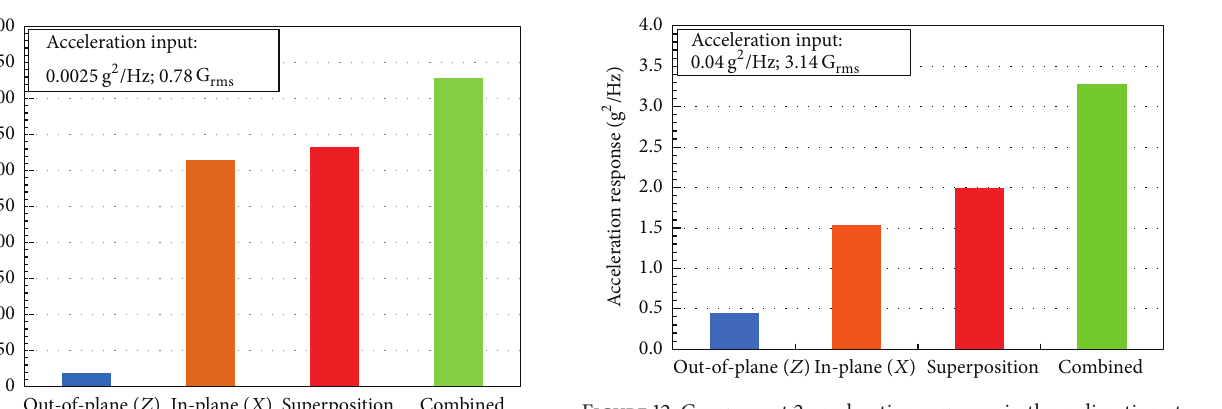
Figure 12: Component 2 acceleration response in the x -direction at 3.14 G rms